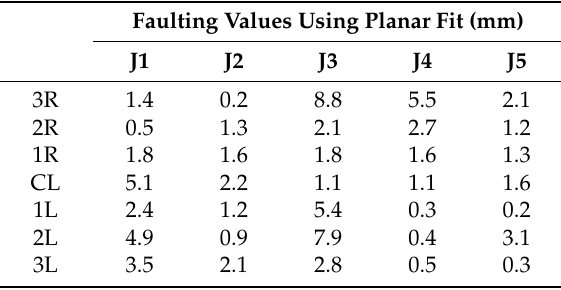
Table 5. Faulting values evaluated in correspondence of the joints.